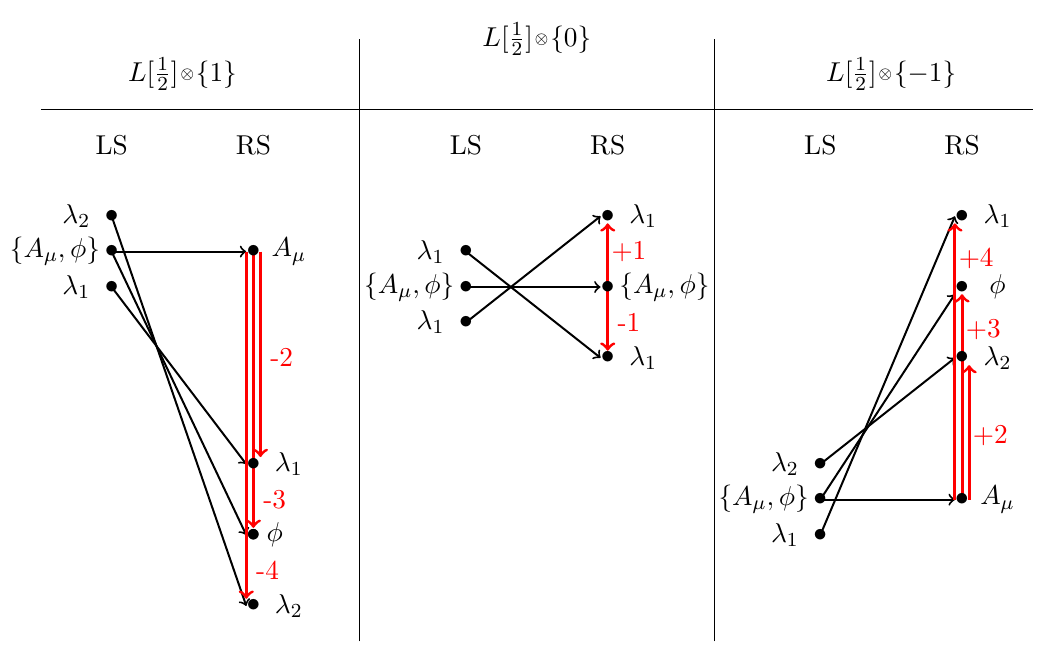
Figure 6 . Shift patterns of the conformal dimensions of the states within L [ 1 left- to the right-squashed S 7 . Here, A µ is a vector, λ are fermions with spin 1